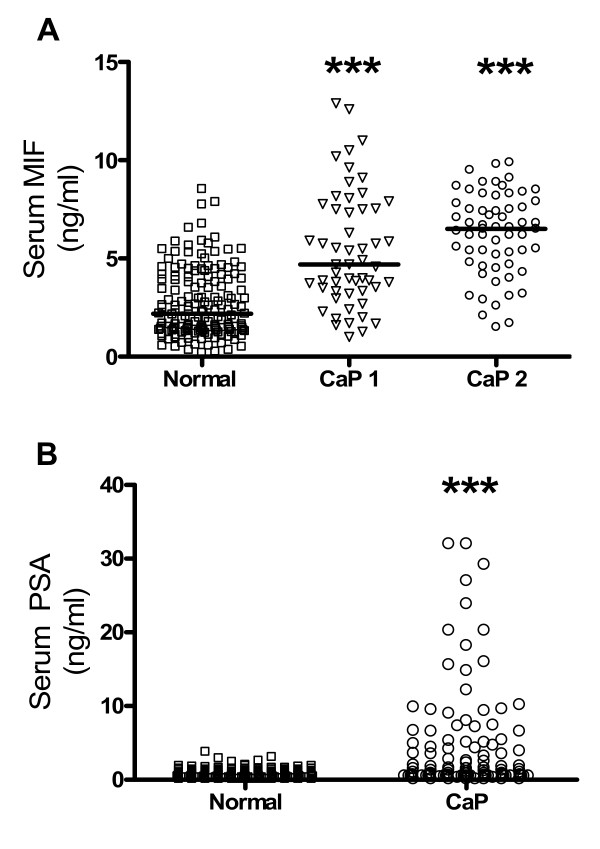
Scatter plots of PSA and MIF in random serum samples obtained following routine PSA testing. Median values for each group are represented by horizontal lines. Diagnosis of prostate cancer was determined by chart review. *** = p < 0.001 A) Serum MIF – All data points were mean values of duplicate ELISA analyses. B) Serum PSA – All data were obtained from computerized records of clinical laboratory analysis.